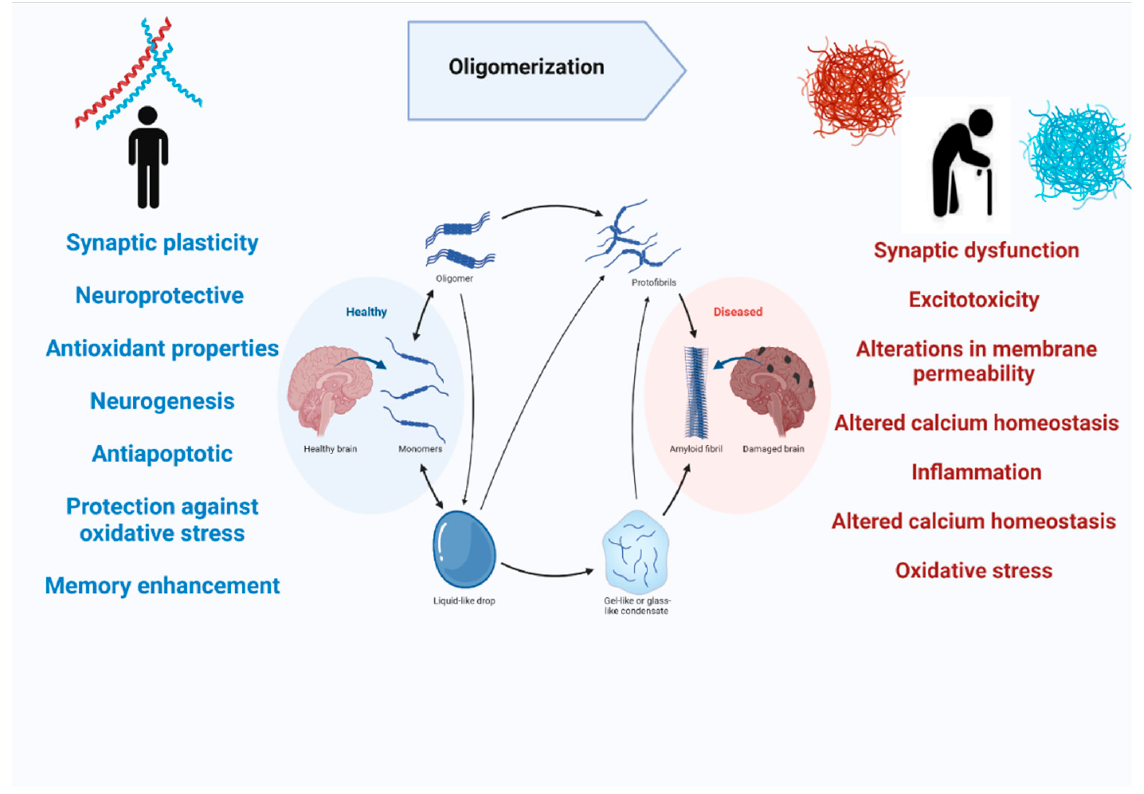
Figure 4. The physiological and pathological role of amyloid beta in the human brain.